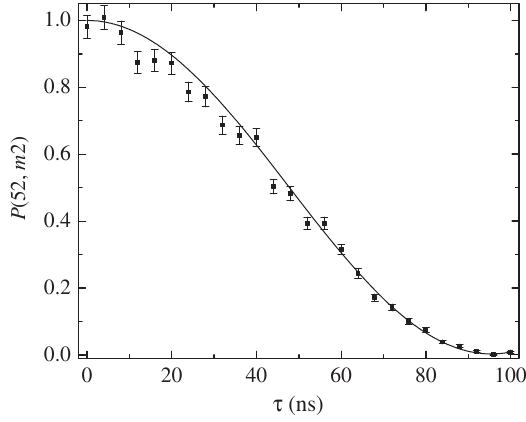
FIG. 9. Preparation of the 52 m 1 state. To normalize the population of 52 m 1 in the superposition state, we modulate the two quadratures of the 250 MHz carrier at 59.5 MHz in order to generate a 190.5 MHz rf field that is resonant with the 52 m 2 − 52 m P 1 transition. The points represent the population m 2 remain- ing in the 52 m 2 state as a function of duration τ of the pulse. For τ ¼ 88 ns, we measure P ≈ 0 . 3% . The amplitude of the rf is m 2 chosen low enough so that the atoms cannot be transferred into 52 m P < 0 . 5% ). The 3 (numerical simulations estimate that m 3 pulse thus prepares 51 m 1 with more than 99%